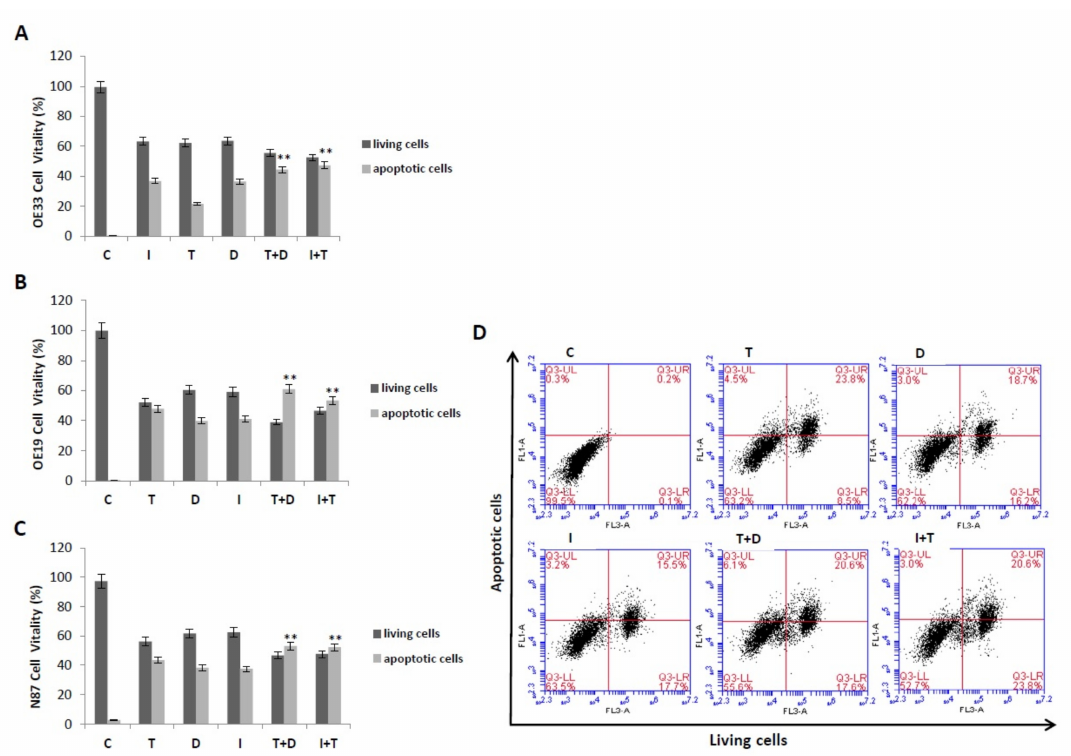
Figure 4. Flow cytometric analysis of OE33 ( A ), OE19 ( B ) and N87 ( C ) cell apoptosis after treatment with Trastuzumab, Ipatasertib and Duligotuzmab, as single agent and in combination. One representative experiment is shown. Dot plot diagrams shown the different stages of apoptosis: % indicated in the upper quadrant represent cells positive for Annexin V, % in lower quadrant represent viable cells. In the histogram plot, dark column corresponds to living cells and clear column to apoptotic cells. (C: untreated control, T: Trastuzumab, D: Duligotuzumab, I: Ipatasertib, Trastuzumab with Duligotuzumab, T+D; Ipatasertib with Trastuzumab, I+T). Each of them represents mean values obtained from three separate experiments. Asterisks indicate statistical significance (** p ≤